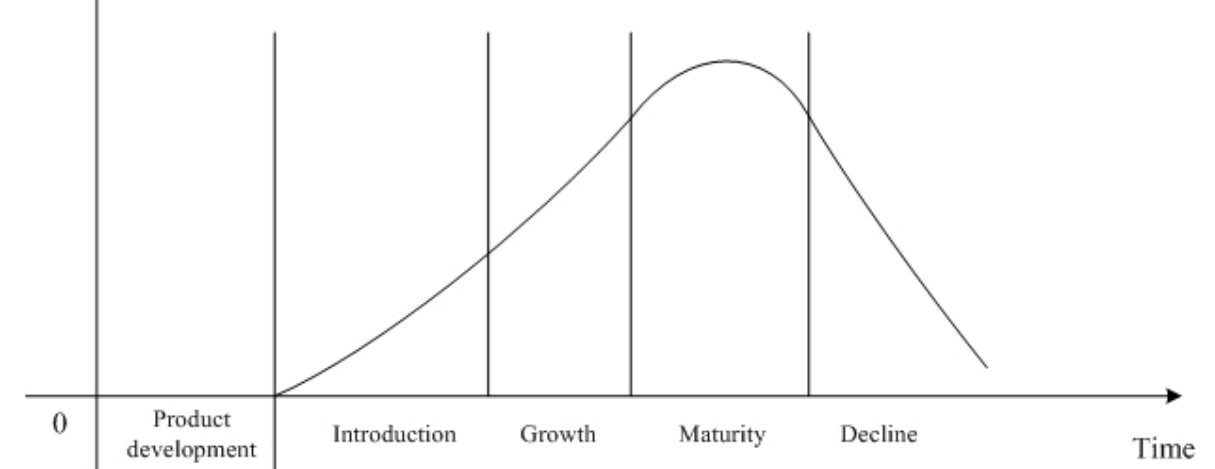
Figure 1. Sales over a product’s life, from inception to decline.